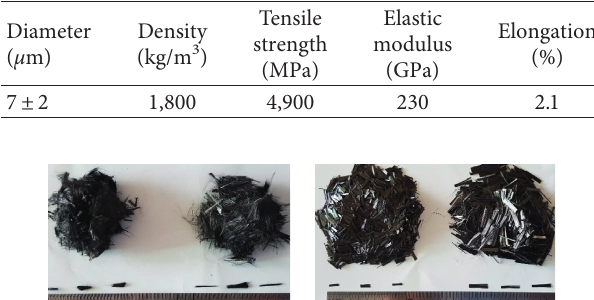
Table 3: Physical properties and shapes of carbon